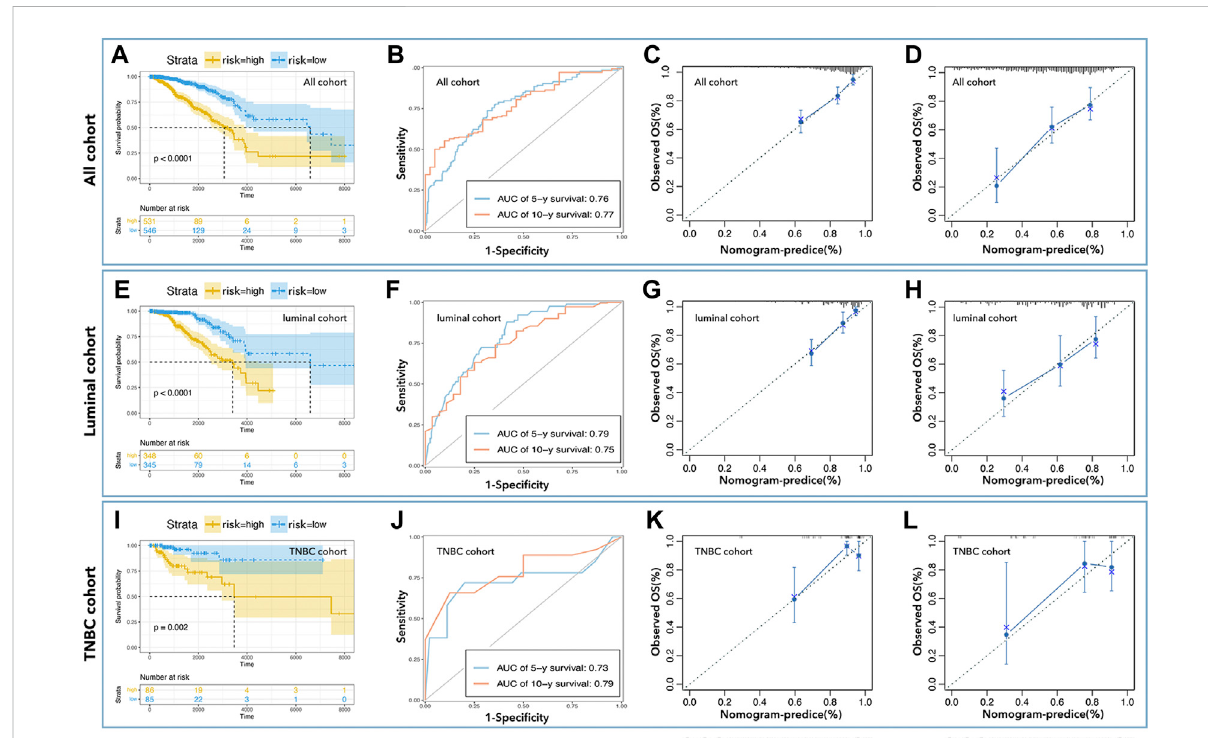
FIGURE 4 Innerveri fi cationofmonogram.K-Mcurveshowedlow-riskwithbetterprognosisinallcohorts (A) ,theluminalcohort (E) ,andtheTNBCcohort (I) . The AUC values of nomograms in all cohorts (B) were 0.76 (5-year survival) and 0.77 (10-year survival), in the luminal cohort (F) were 0.79 (5-year survival) and 0.75 (10-year survival), and in all cohort (J) were 0.73 (5-year survival) and 0.79 (10-year survival). Calibration analysis was performed to assess the prediction accuracy of nomograms in all cohorta (C,D) , luminal cohort (G,H) , and TNBC cohort (K,L)